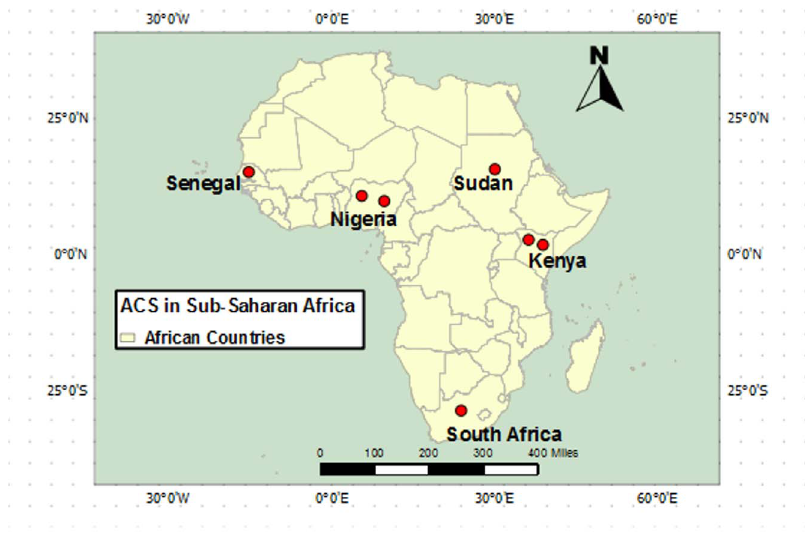
Figure 3. Locations of studies of AMI in Sub-Populations of Sub-Saharan Africa. doi:10.1371/journal.pone.0096688.g003 PLOS ONE |